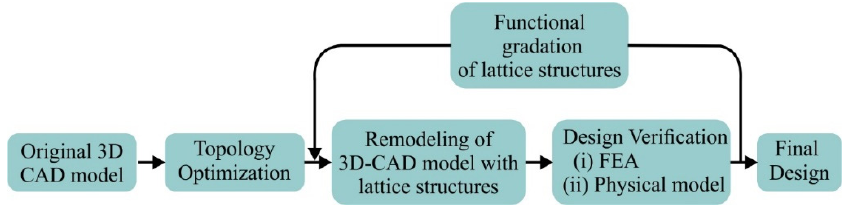
Figure 1. Flowchart of topological optimization procedure.